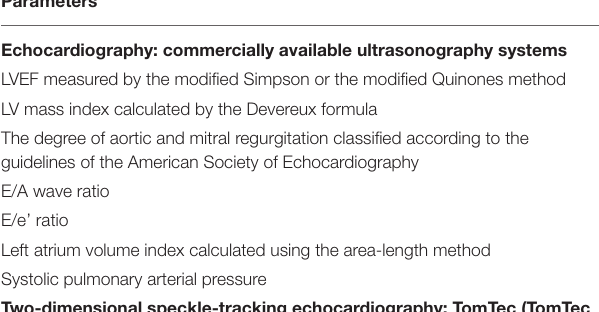
TABLE 3 | Parameters of echocardiography, 2D STE, ECG and circulating biomarkers.